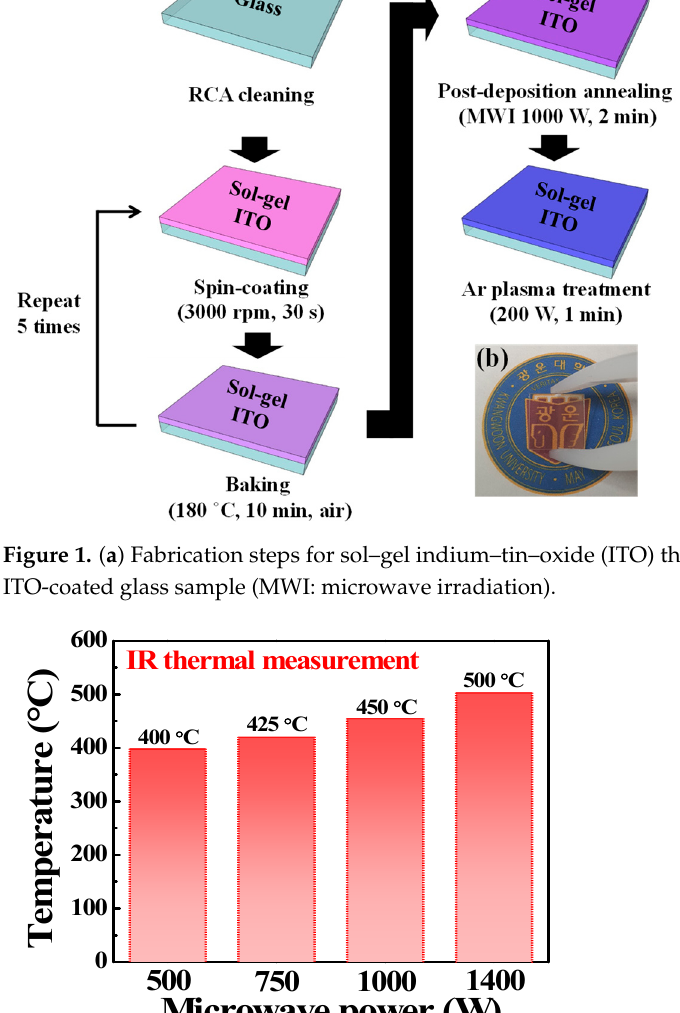
Figure 1. ( a ) Fabrication steps for sol–gel indium–tin–oxide (ITO) thin films; ( b ) photograph of the ITO-coated glass sample (MWI: microwave irradiation).